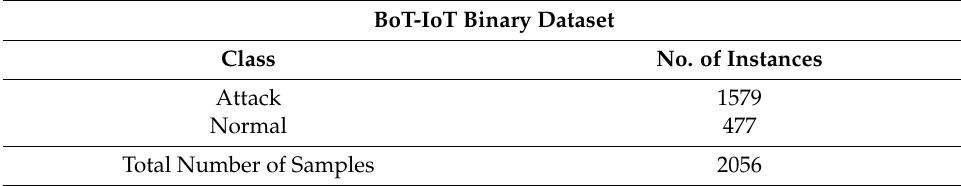
Table 2. Details of the multiclass dataset.